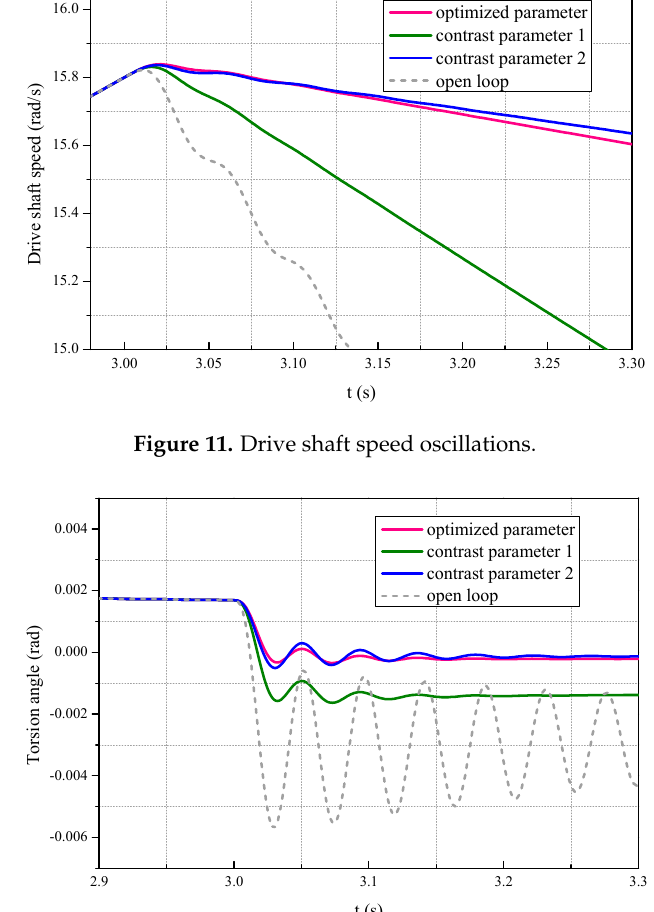
Figure 12. Torsion angle of drive shaft.